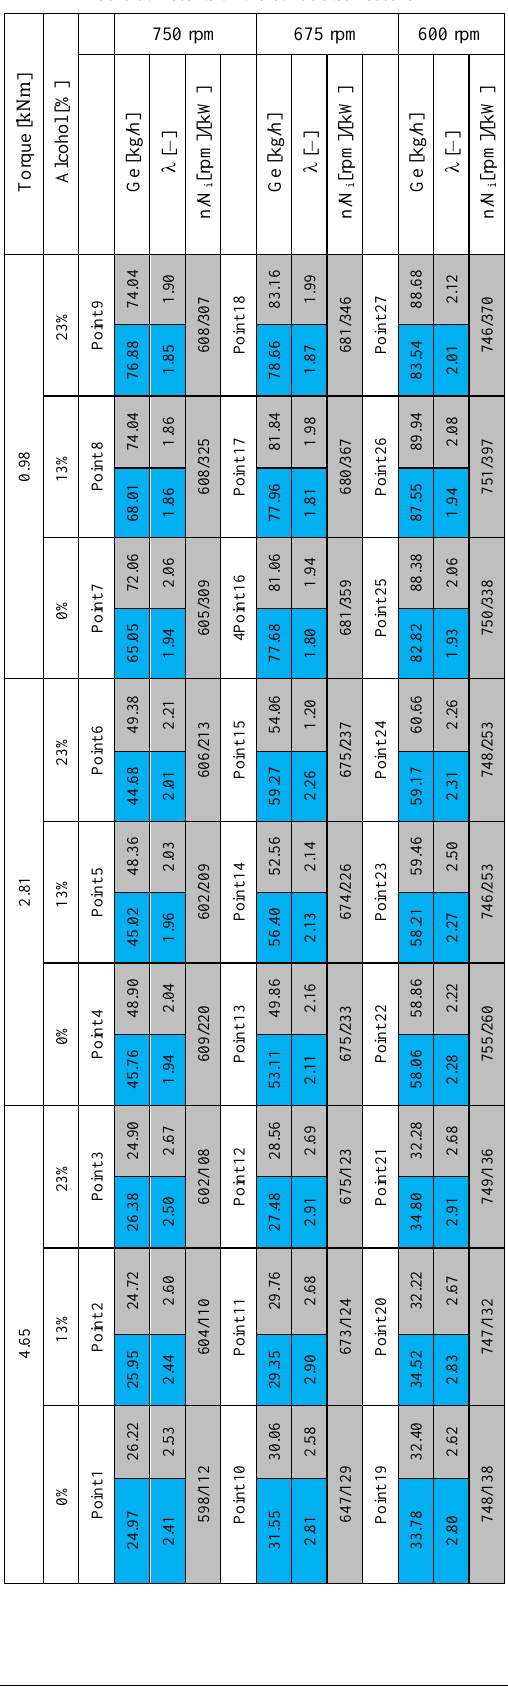
Table 5. Results of the conducted